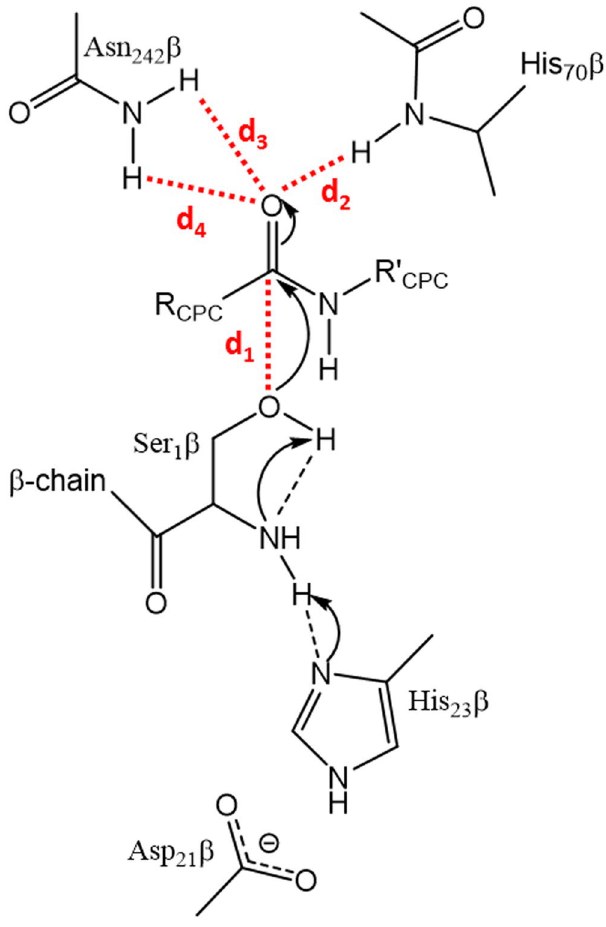
Figure 9. Schematic representation of the first step of the proposed catalytic mechanism. The substrate is assumed to bind in a ground state conformation which is closely related to the transition state of the chemical reaction: the Near Attack Conformation (NAC). The four distances used for calculating d NAC are indicated in red and